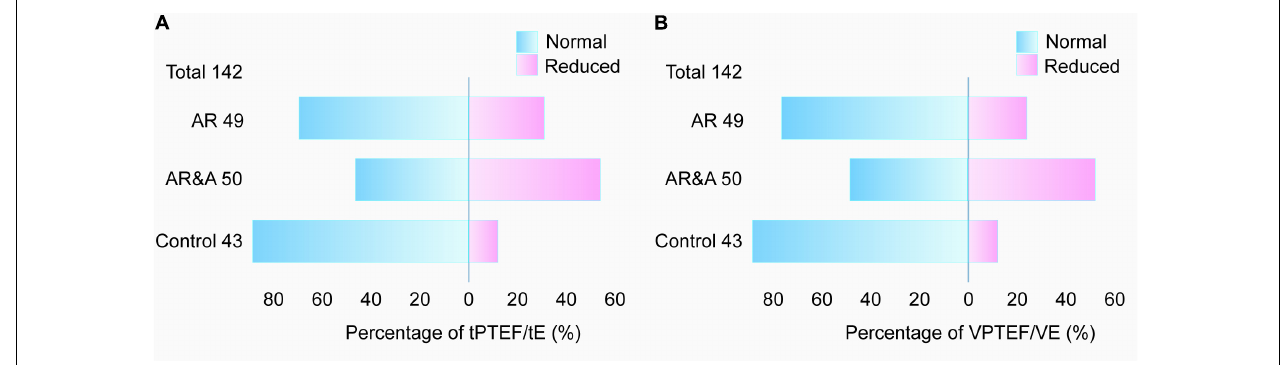
FIGURE 2 | Comparison of abnormal proportion of (A) tPTEF/tE and (B) VPTEF/VE among three groups. The total number of participants is 142, including 49 in AR group, 50 in AR&A group, and 43 in control group. The proportions of abnormal tPTEF/tE and VPTEF/VE were different among the three groups, the highest in AR&A group, the second in AR group and the lowest in control group. Blue, percentage of participants with normal tPTEF/tE or VPTEF/VE; Pink, percentage of participants with reduced tPTEF/tE or VPTEF/VE. AR, allergic rhinitis; AR&A, allergic rhinitis concomitant with asthma; tPTEF/tE, ratio of time to reach peak tidal expiratory flow to